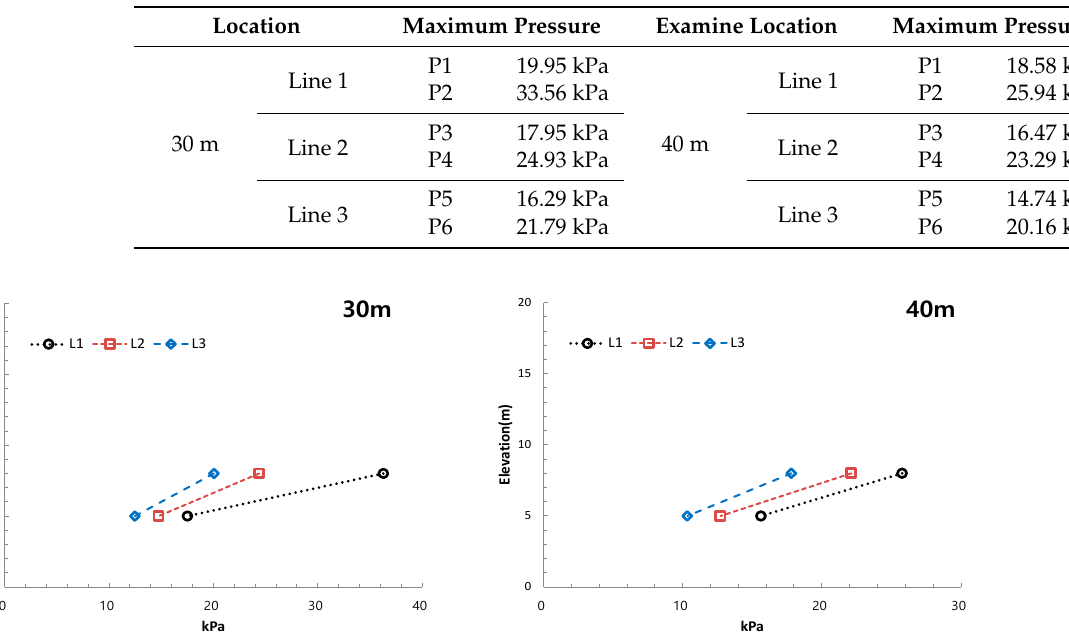
Figure 8. Distribution of the maximum wave pressure.